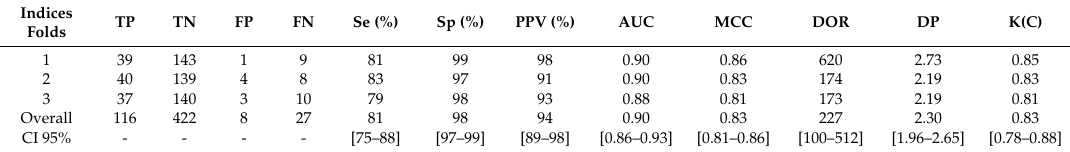
Table 3. The performance indices of the proposed prediction